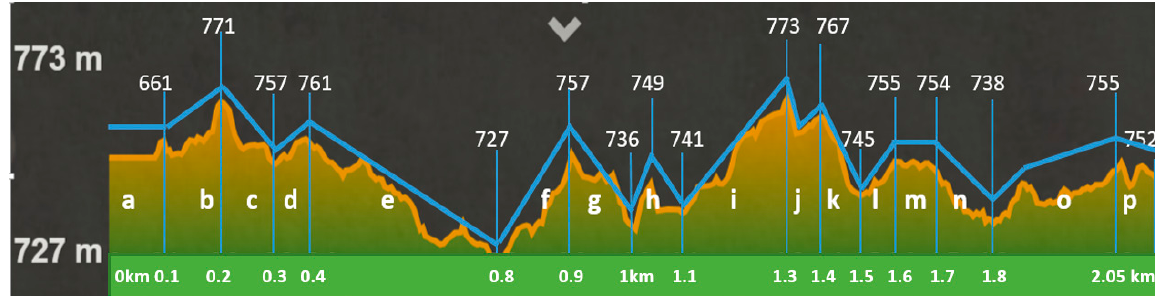
Figure 12. Riacho do Meio Altimetry trail, Araripe UGG. Source: Wikiloc; adapted for the study [40]. a–p: Route sections.